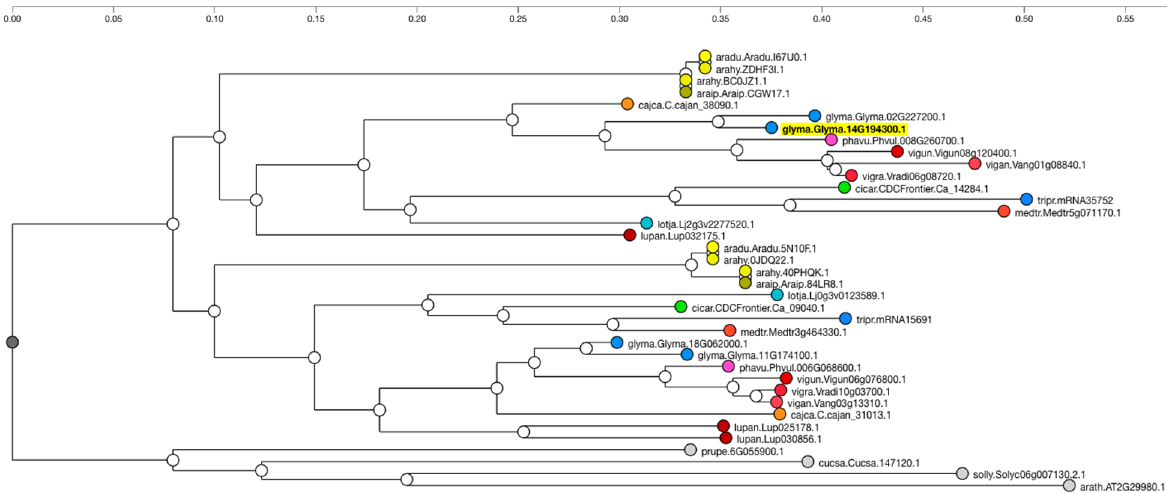
Figure 6. Orthologs of Glyma.14g194300 . The phylogram derived from the Legume Information Service’s Phylotree viewer. Sequences with high sequence similarity to Glyma.14g194300 (highlighted in yellow) are from Common Bean (phavu), Cowpean (vigun), Adzuki Bean (vigan) and Mung Bean (vigra). Larger version.